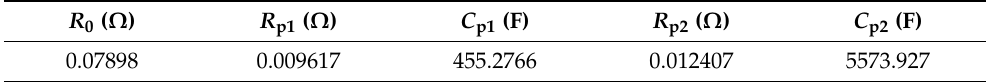
Table 2. The battery model parameters.